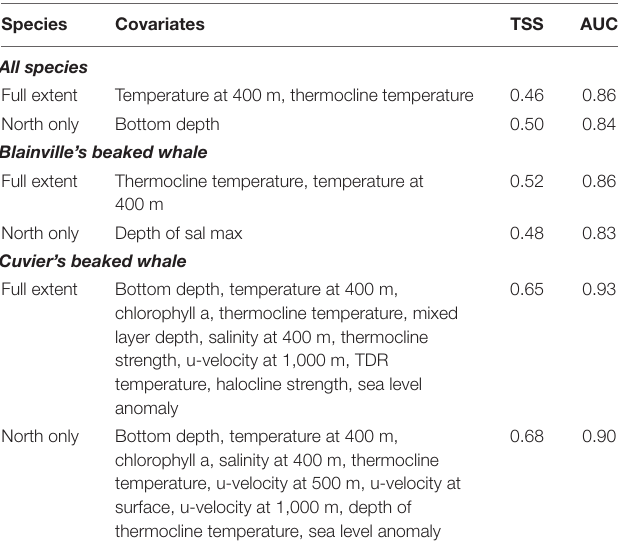
TABLE 4 | Performance evaluation criteria for the six Ensemble Random Forest models with the environmental covariates that had a mean decrease accuracy greater than 5% of the total number of whale detections for that particular